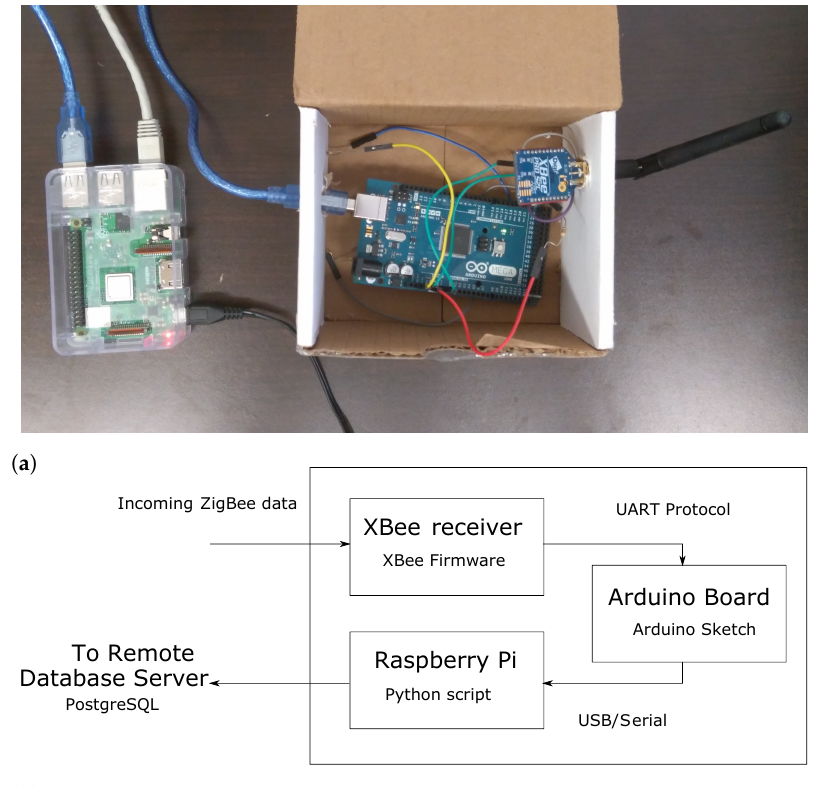
Figure 2. The base station (prototype version) and data flow. ( a ) A prototype of the base station. (Left): Raspberry Pi, (Right): Arduino and Xbee Pro © receiver; ( b ) data flow inside the base station.